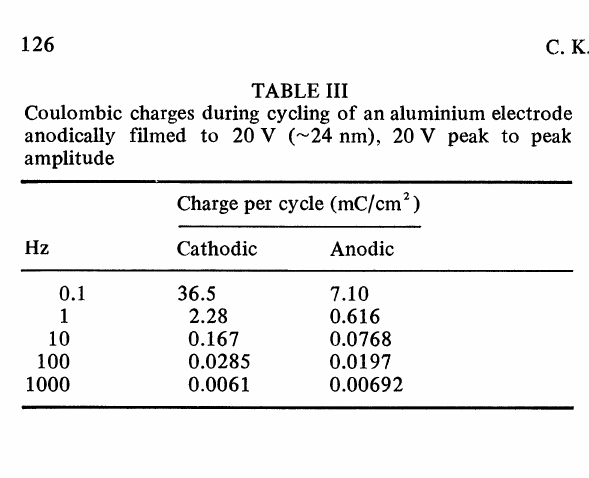
TABLE III Coulombic charges during cycling of an aluminium